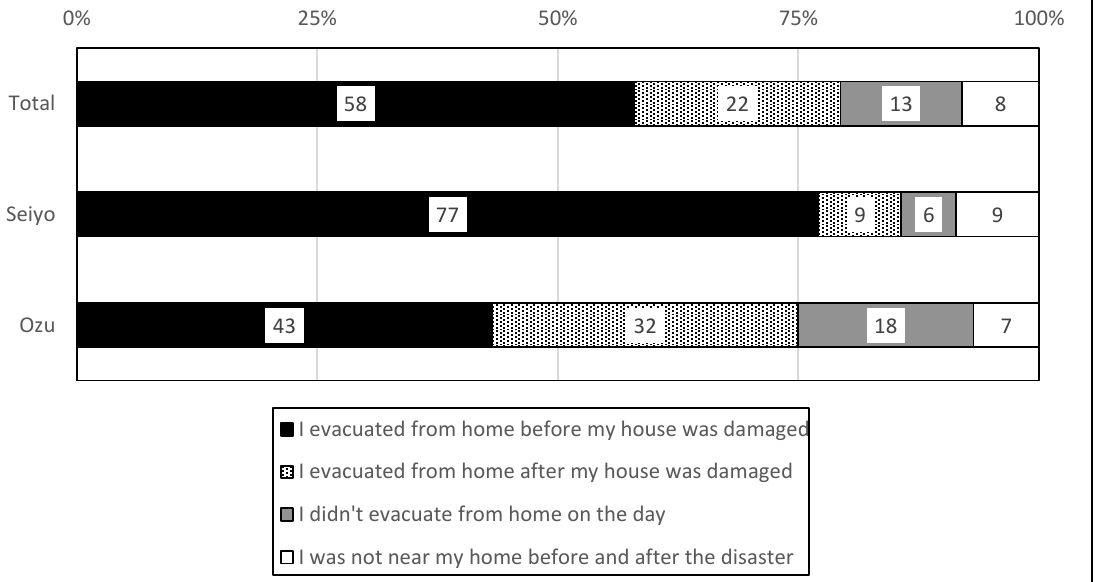
Figure 14. Evacuation rate (%), n = 79.